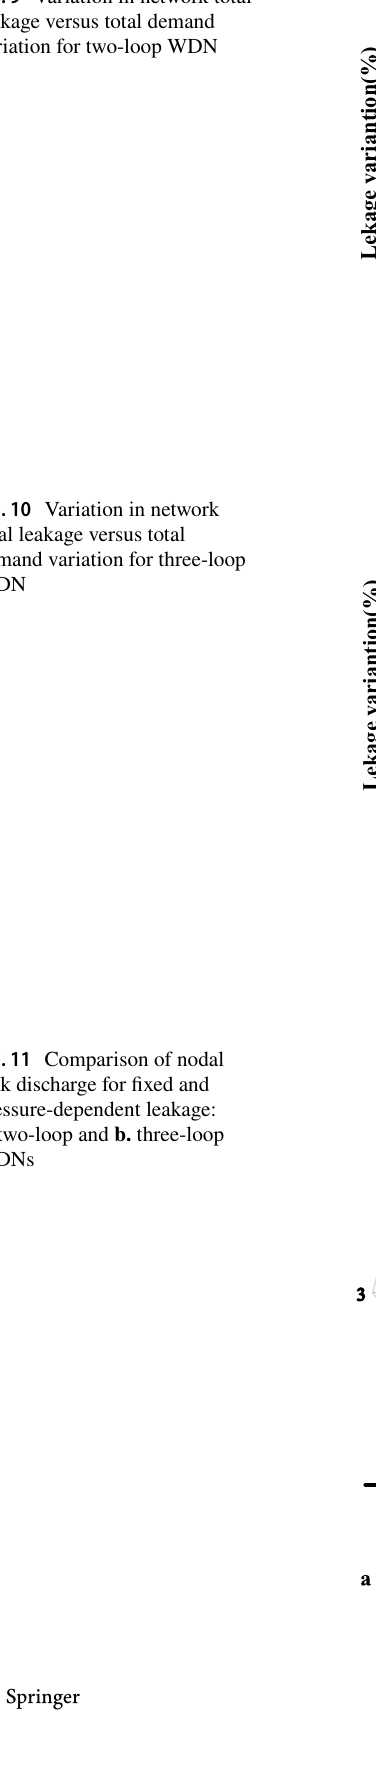
Fig. 9 Variation in network total leakage versus total demand variation for two-loop WDN